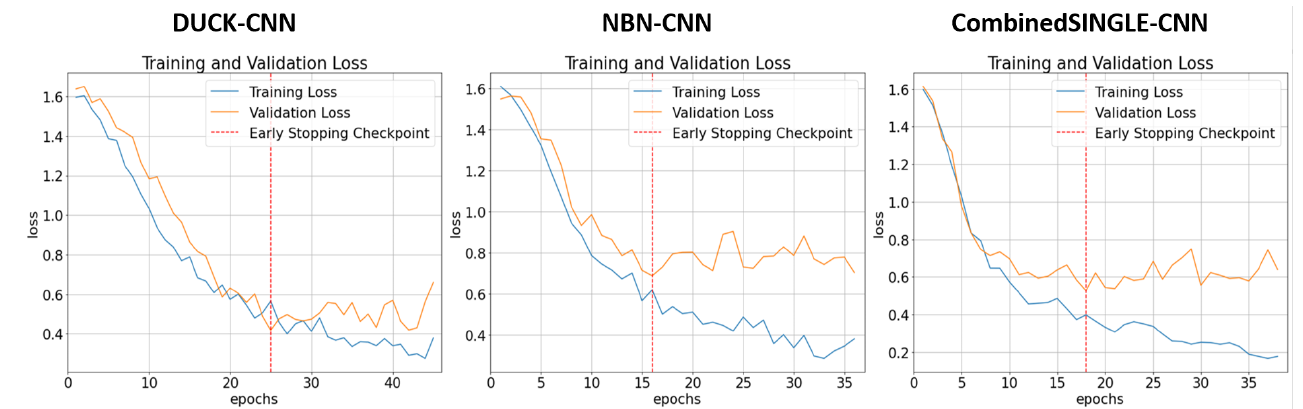
Figure A1. The training and validation losses of training the models: DUCK-CNN ( left ), NBN-CNN ( middle ) and CombinedSINGLE-CNN ( right ). On the y -axis is the loss, and on the x -axis is the number of epochs. The red dotted line indicates the early stopping